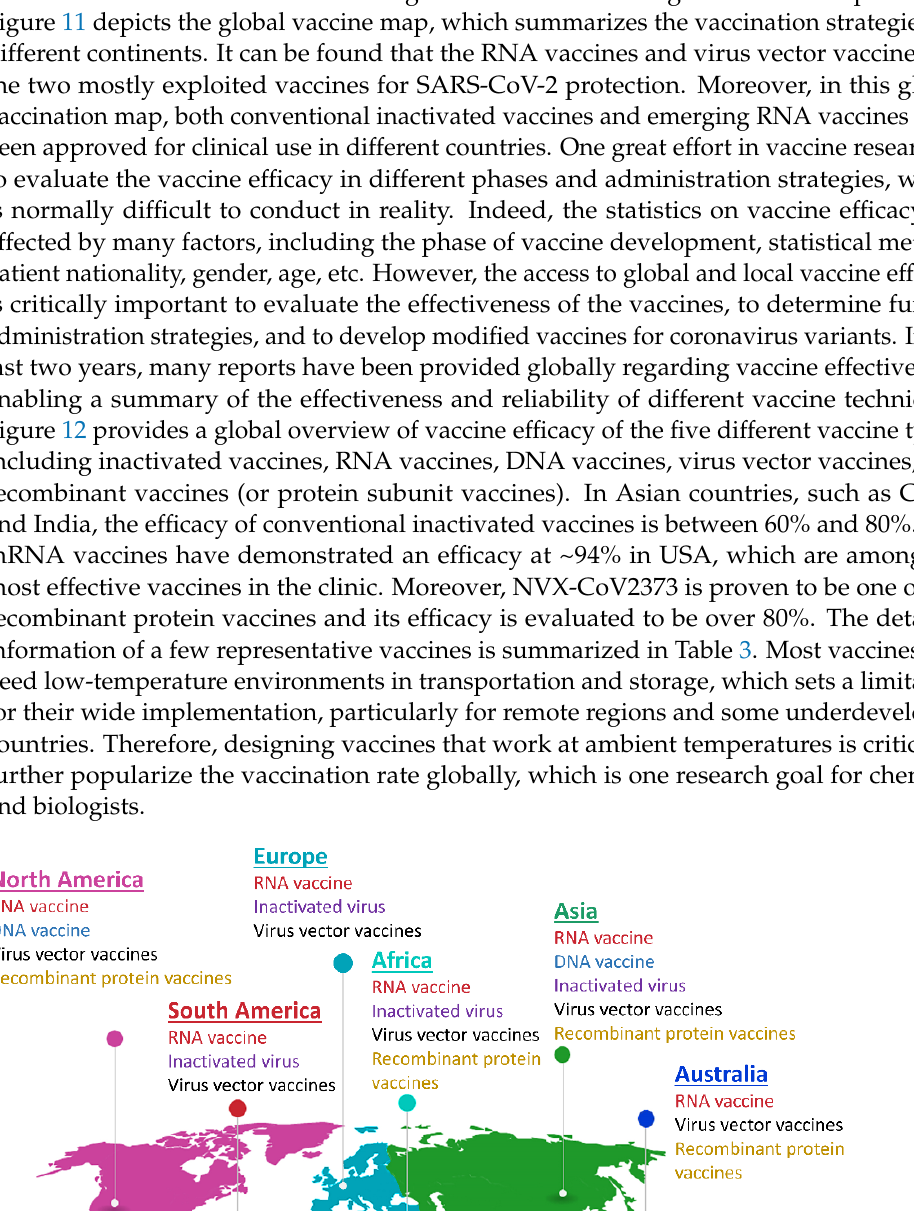
Figure 12. Global vaccine efficacy maps in different countries. The vaccines that have been used in different countries are color-coded by the vaccine types (RNA vaccine, DNA vaccine, inactivated